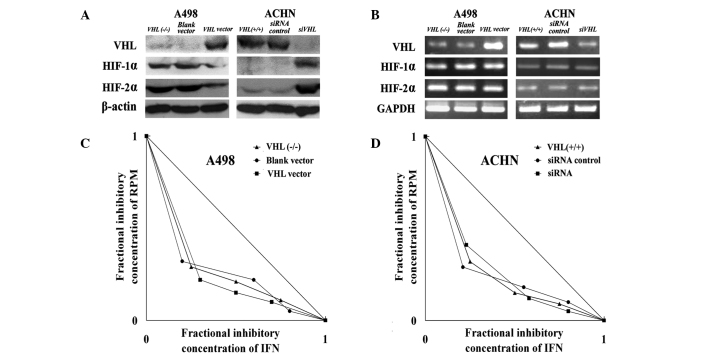
Effect of VHL activity on the synergy of IFN-α and RPM. VHL expression of VHL was downregulated in ACHN cells by RNAi and upregulated in A498 cells by transfection with a VHL vector, as confirmed by (A) western blot analysis and (B) RT-PCR. Isobolographic analysis demonstrated the effect of combination therapy with IFN-α and RPM on (C) A498 and (D) ACHN RCC cell lines. VHL, Von Hippel-Lindau; IFN, interferon; RPM, rapamycin; HIF, hypoxia-inducible transcription factor; RT-PCR, reverse transcription polymerase chain reaction; RCC, renal cell carcinoma.